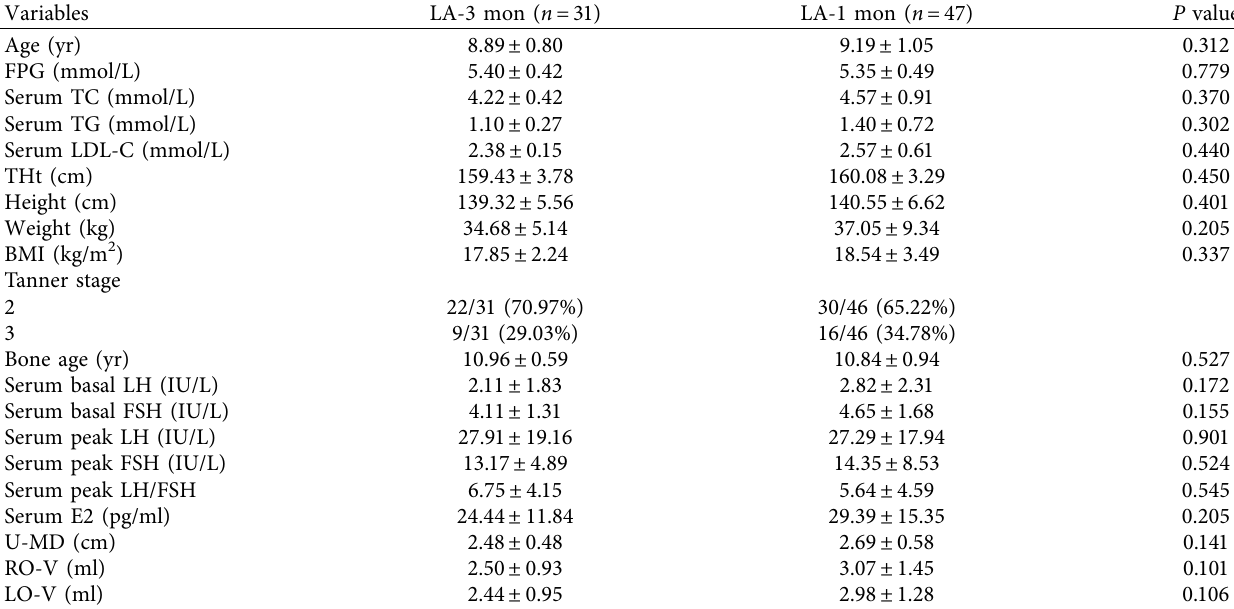
Table 1: Baseline characteristics of the LA 3-month depot and 1-month depot groups. Variables